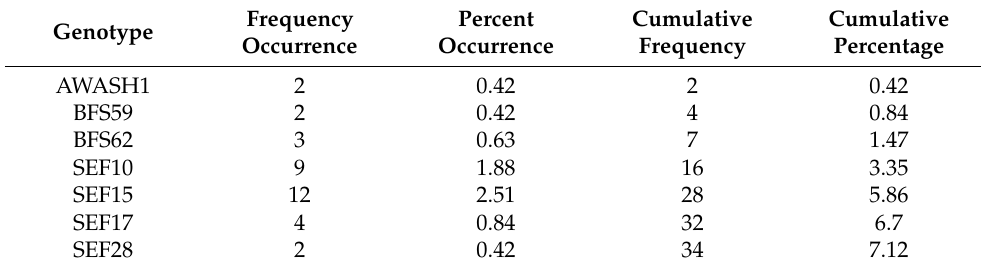
Table 9. Seed-podding frequency of drought-tolerant bean genotypes during terminal drought under screen-house